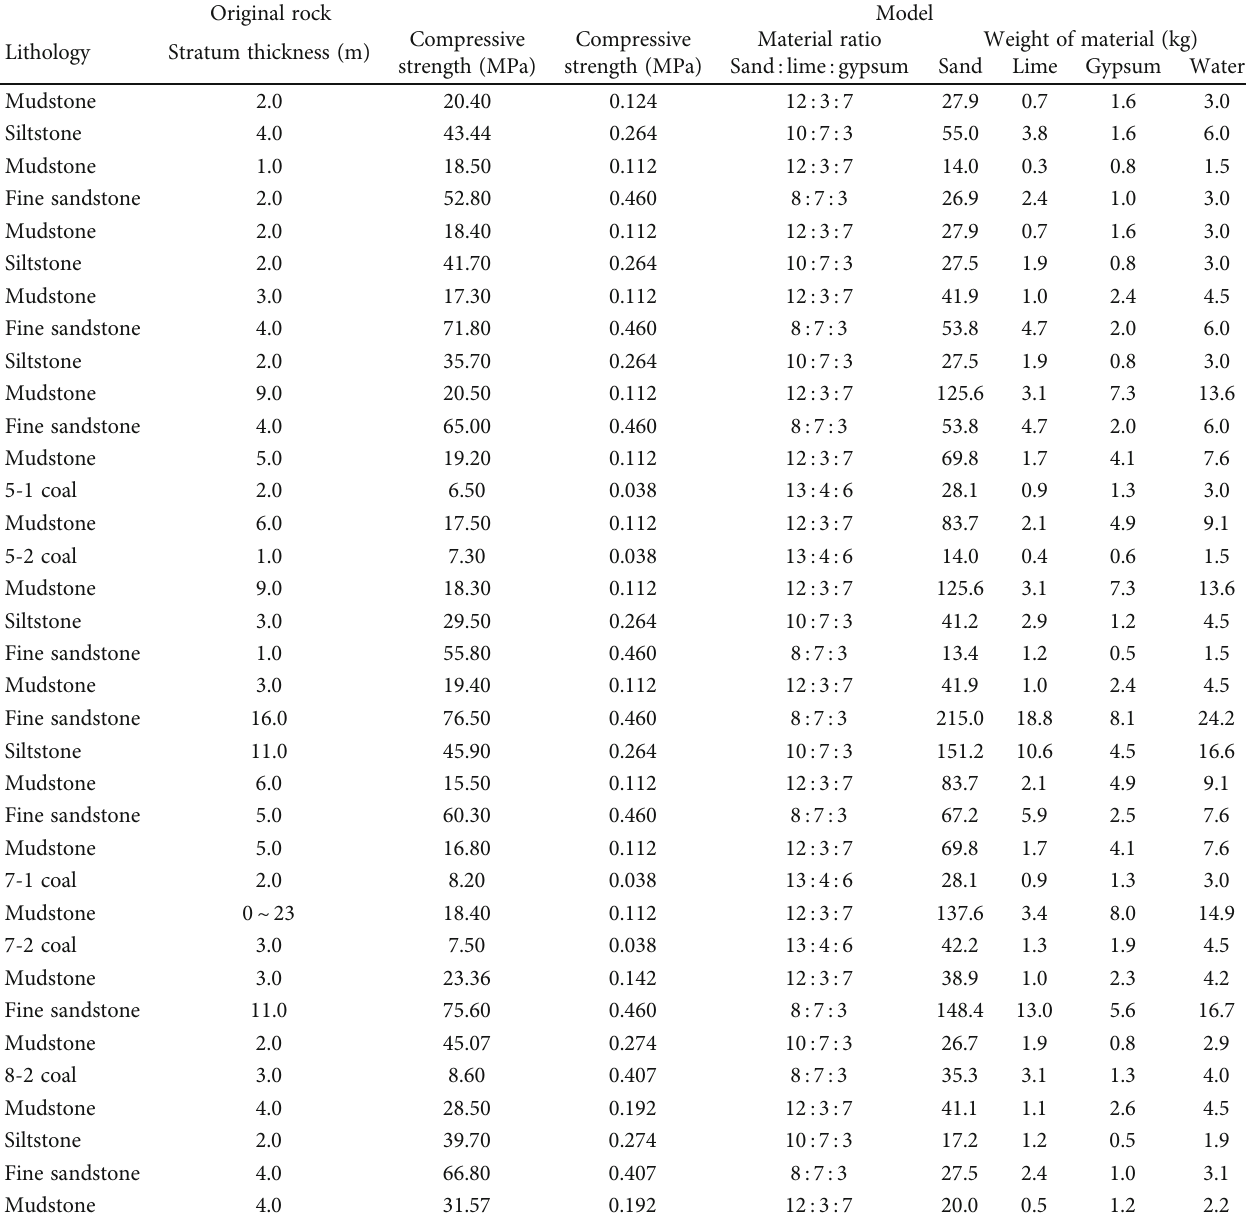
Table 2: Material parameters and mixing